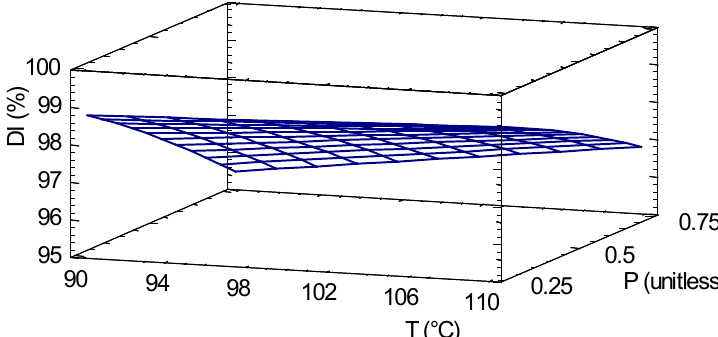
Figure 5. Estimated response surface for the mechanical durability index considering the process temperature and the proportion of rice husk in the biomass mixture for a compaction time of 40 s.